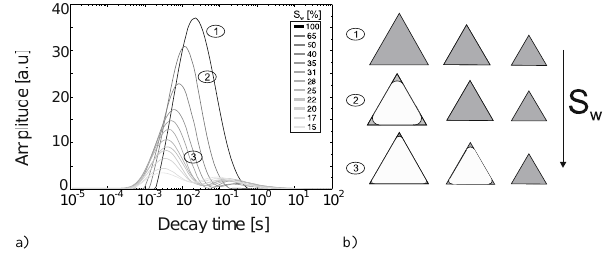
Figure 12. (a) NMR decay time distributions at different water satu- ration levels for a pore distribution of equilateral triangles. (b) Con- cept sketch of saturated (gray) and desaturated triangular capillaries for increasing pressure levels (1), (2) and (3), e.g., during